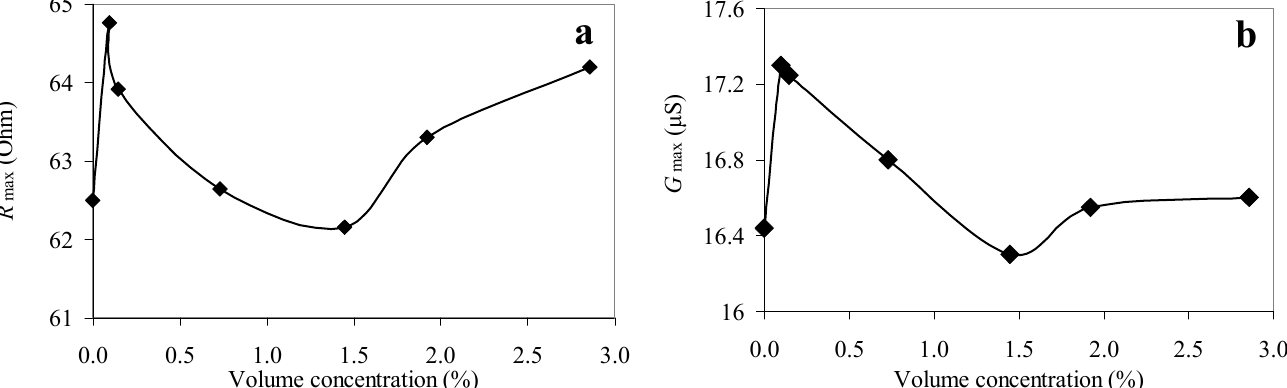
Figure 4. The dependences of the maximum values of the real parts of the electrical impedance ( a ) and admittance ( b ) of the langasite resonator on the volume concentration of the diamond particles in the suspension.